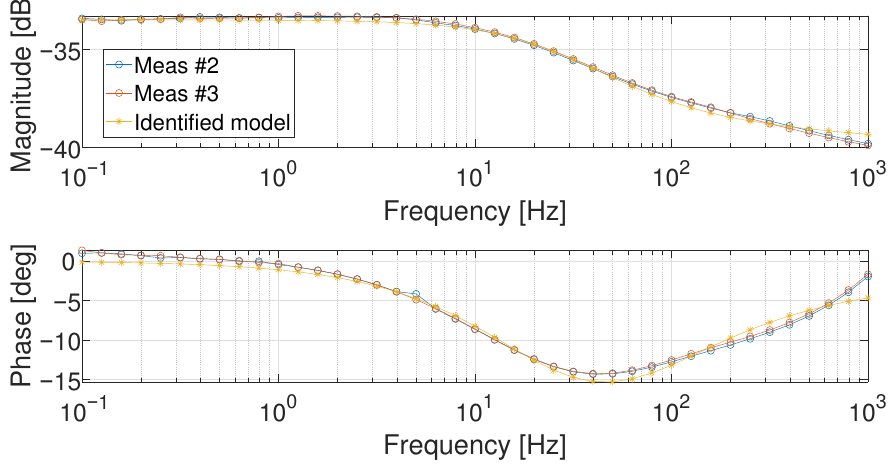
Figure 12. Bode diagrams of the identified Meas #1 at 5A and compared with Meas #2 and Meas #3 . It is also quite evident that, for the validation pattern, the obtained models describe correctly the fuel cell behavior at the analyzed working current points. The identified parameters for each working current point were evaluated and are reported in the following (see Figure 13 and Table 1). Table 1. Identified parametervalues for (8) exploiting the first approach identification strategy. Working